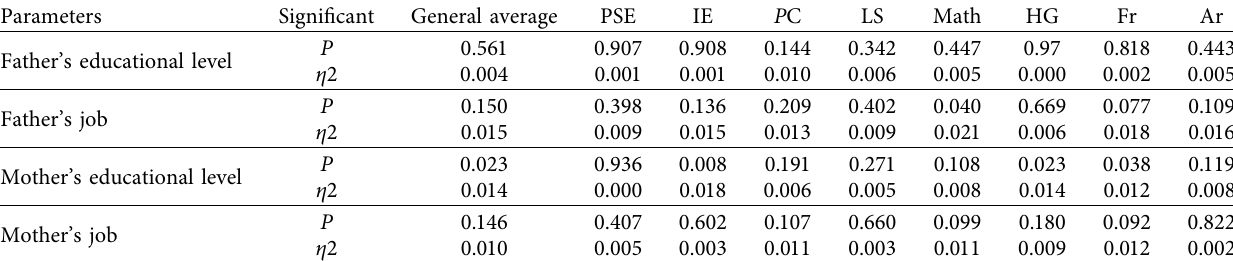
Table 5: Effect of parents’ job and educational level on student’s academic